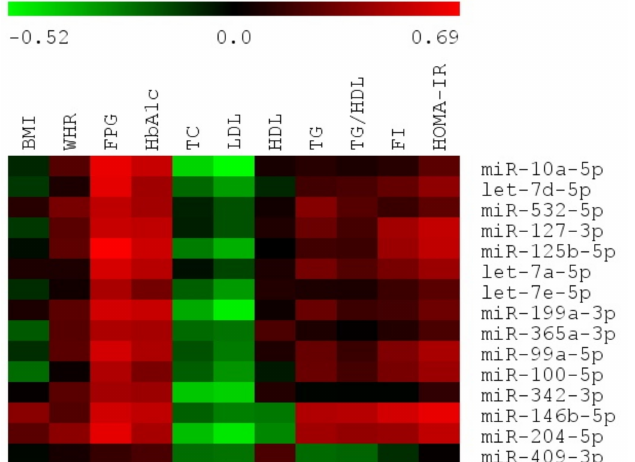
Figure 6. Heatmap of Spearman rank correlation coefficients calculated among expression levels of 15 DE miRNAs and anthropometric and biochemical parameters for female study